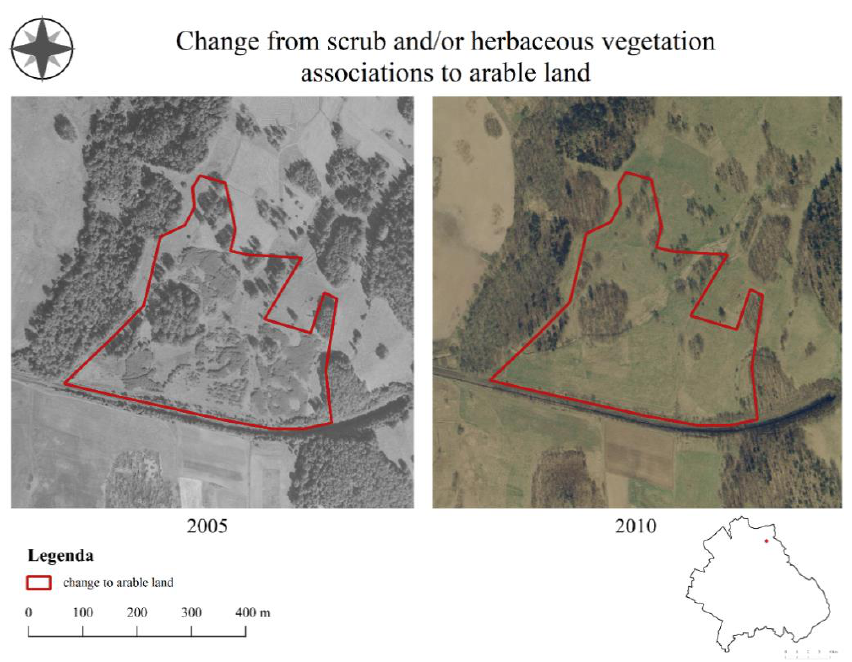
Figure 5. Intensification of the agriculture in the Mysłakowice commune. Natural succession was most strongly affected by changes in the agricultural struc- ture (65.6% of respondents), soil characteristics (56.3%), and agricultural and forestry pol- icies (50%). The change was perceived positively (53.1% positive, and 31.3% very posi- tive).